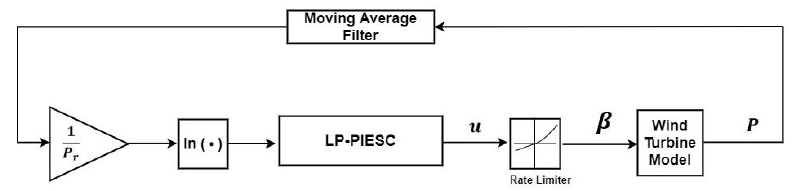
Figure 22. LP-PIESC implementation for blade pitch